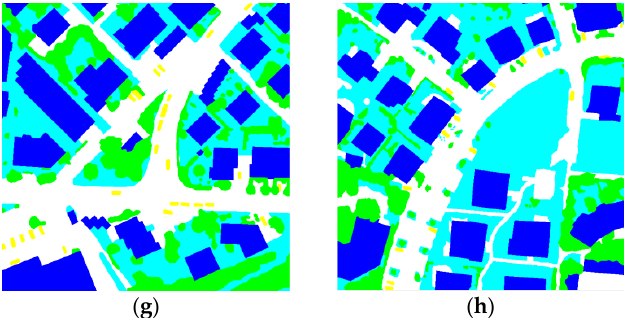
Figure 5. The Vaihingen test area: ( a ) Area 30; ( b ) Area 37; ( c ) the DSM of Area 30; ( d ) the DSM of Area 37; ( e ) the contour of the Area 30; ( f ) the contour of the Area 37; ( g ) the ground truth map of Area 30; and ( h ) the ground truth map of Area 37.